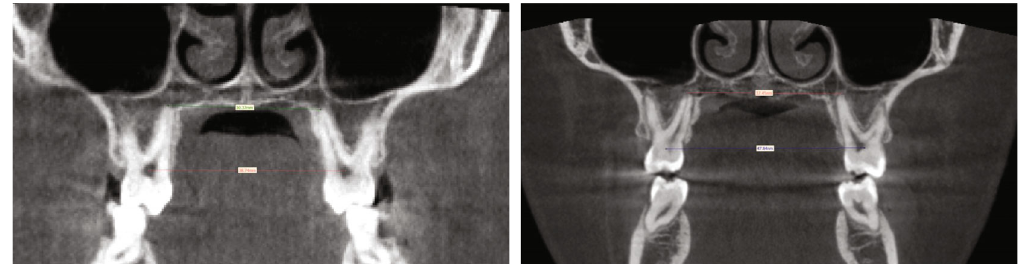
Figure 17: First molar torque evaluation.